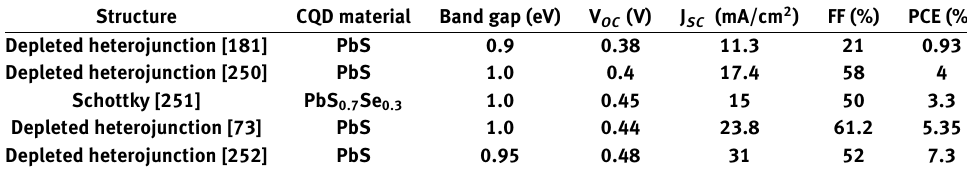
Table 2. Summary of selected optimized studies in single junction CQD solar cells with band gaps near 1